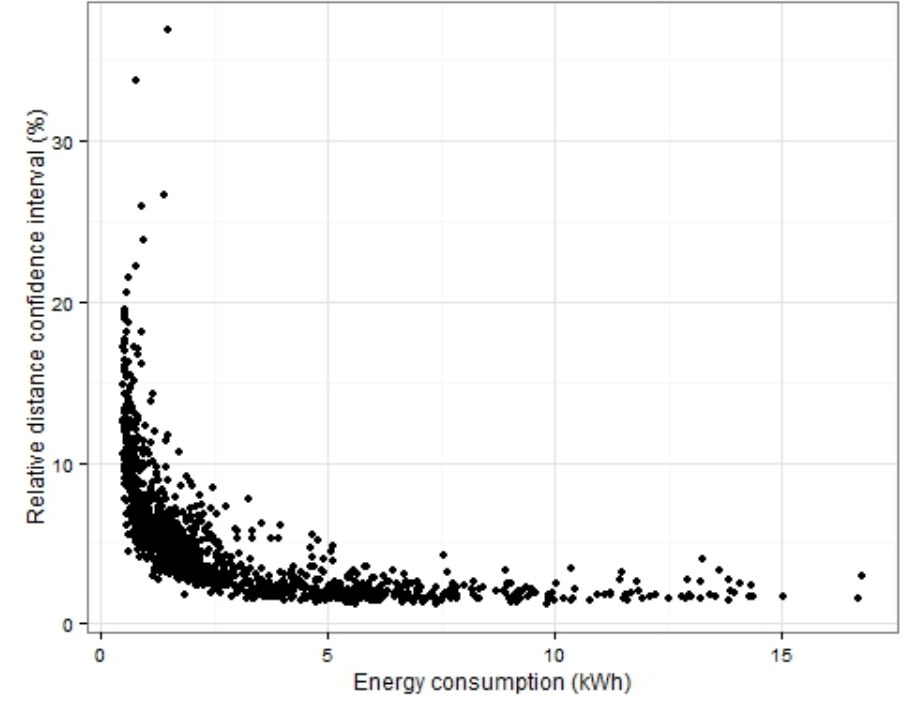
Figure 5. Confidence intervals for the predicted values of the macro model, expressed in relative distance (%) to the predicted